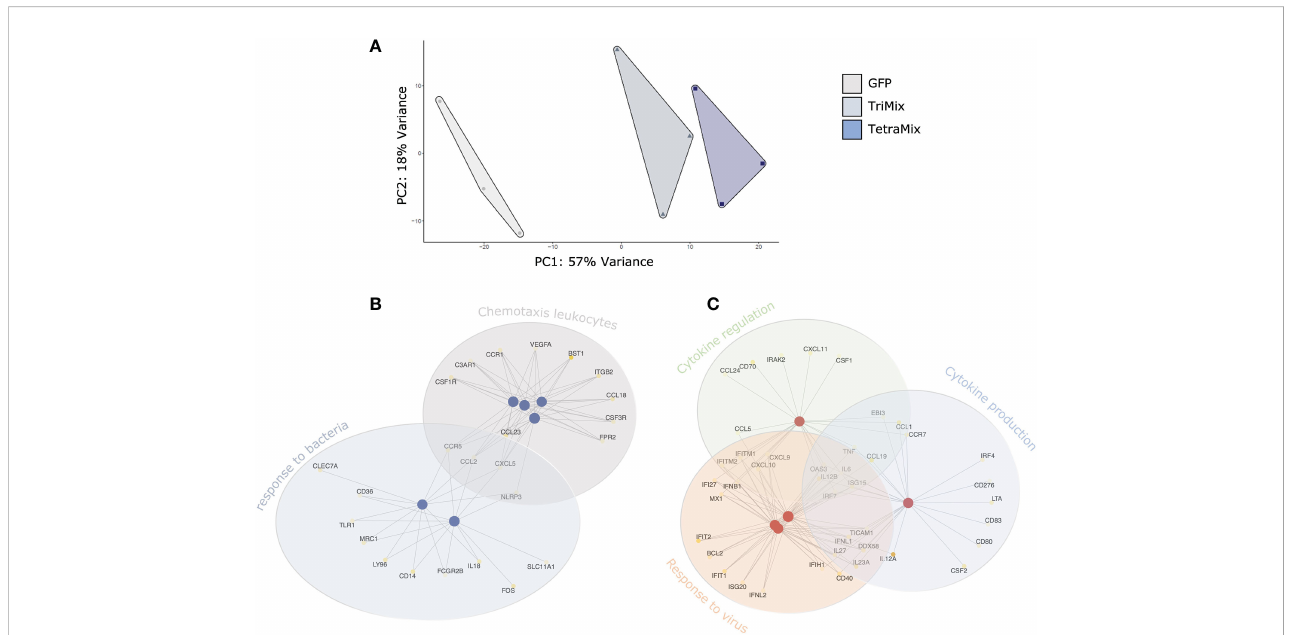
FIGURE 2 TetraMix mRNA induces an antiviral transcriptional program. Gene ontology network plots reveal the transcriptional alterations in biological processes between TriMix- and TetraMix-reprogrammed DCs (referred to as ‘ TriMixDCs ’ and ‘ TetraMixDCs ’ ). (A) Principal component analysis (PCA) of the transcriptomic analysis on dendritic cells 24 hours after electroporation (for each condition, i.e. GFP, TriMix and TetraMix, n=3). (B) Network plot of the top 6 biological processes and the involved genes that are downregulated in TetraMixDCs compared to TriMixDCs. Each node represents a gene set ( i.e ., a GO term). (C) Network plot of the top 5 biological processes and the involved genes that are upregulated in TetraMixDCs compared to TriMix DCs. Each node represents a gene set ( i.e. , a GO term). Statistical signi fi cance is quanti fi ed using the gene score (-log 10 adjusted p-value) and visualized via a yellow-to-white color palette, ranging from highest to lowest signi fi cance